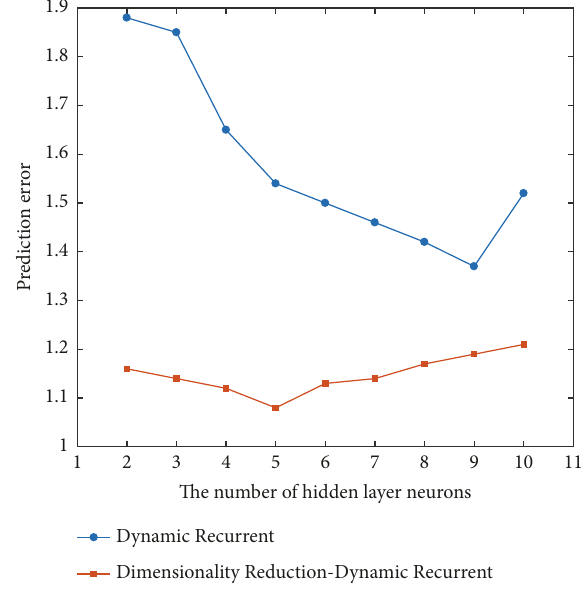
Figure 8: MAPE value and the number of